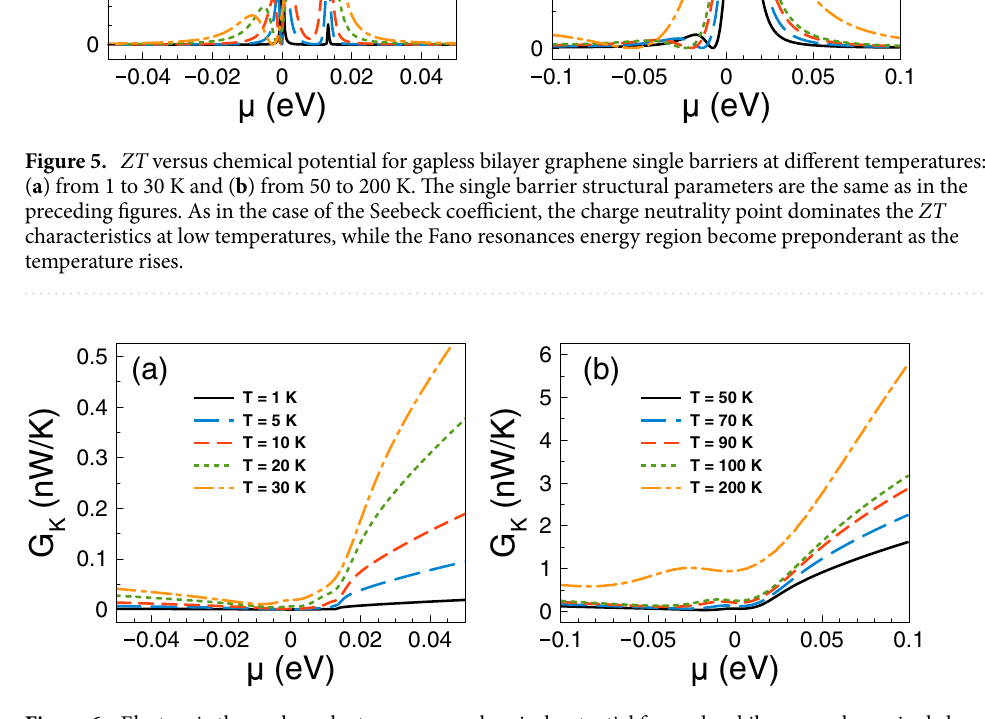
Figure 6. Electronic thermal conductance versus chemical potential for gapless bilayer graphene single barriers at different temperatures: ( a ) from 1 to 30 K and ( b ) from 50 to 200 K. The single barrier structural parameters are the same as in the preceding figures. The electronic thermal conductance is similar to the electrical conductance. However, the ratio of G K to GT is not at all the Lorenz number, resulting in values of ZT an order of magnitude lower than in strained single layer graphene 54 . More details about G K /( GT ) can be found in the supplementary